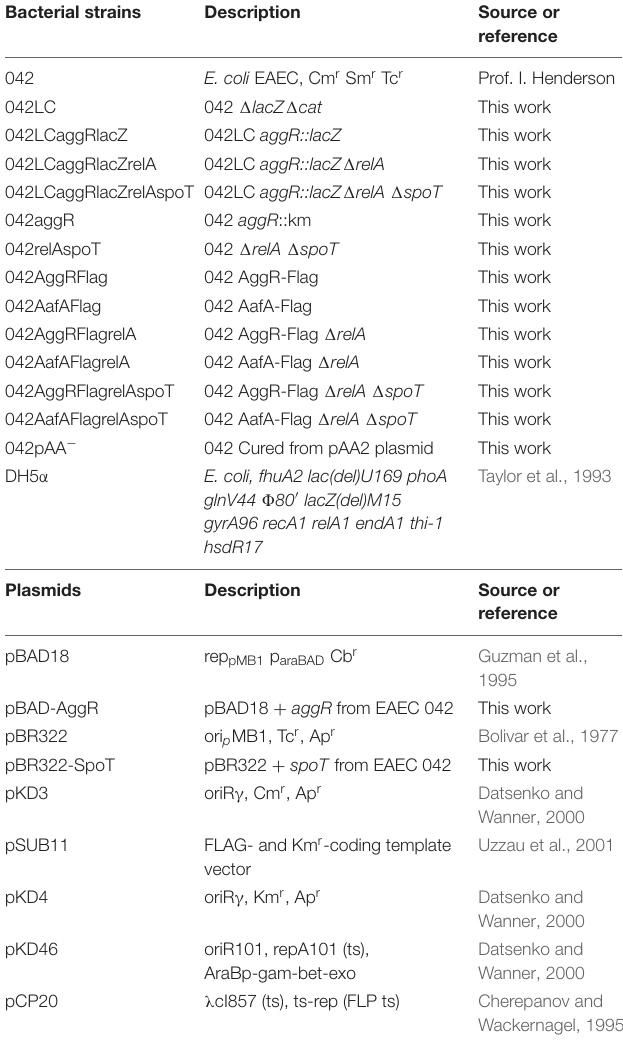
TABLE 1 | Bacterial strains and plasmids used in this